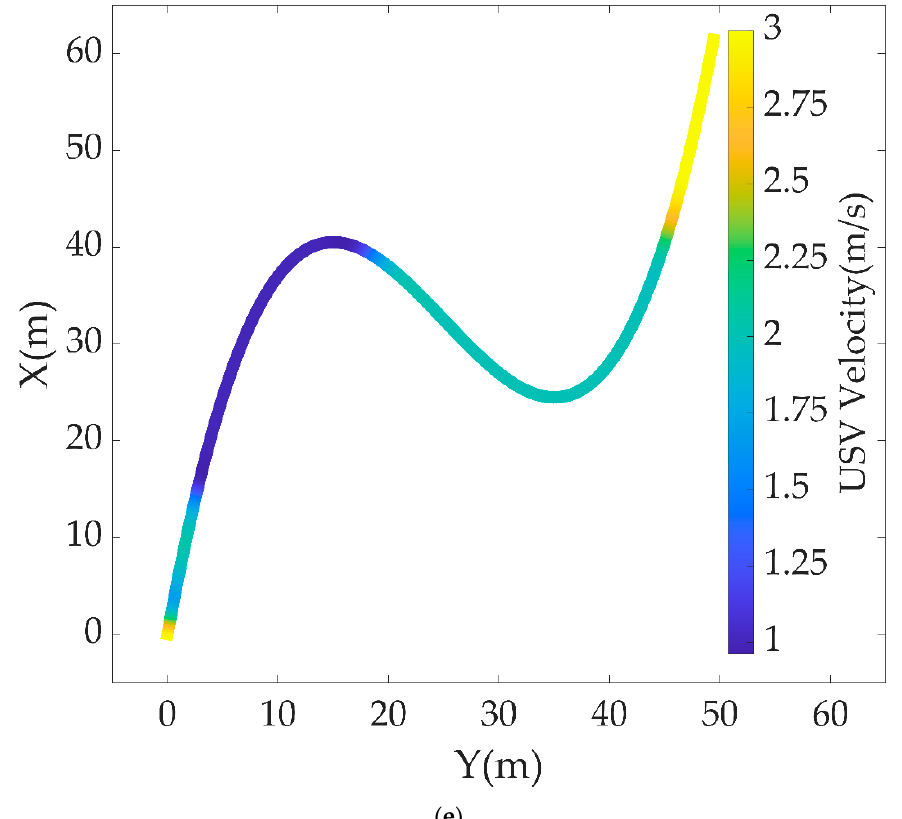
Figure 7. Results of USV underlying motion control: ( a ) USV 3-DOF motion data; ( b ) Tracking effect of RVC on expected velocity; ( c ) Tracking effect of NBCC on LOS guidance law; ( d ) Thrust and torque output; ( e ) USV resultant velocity on its trajectory.